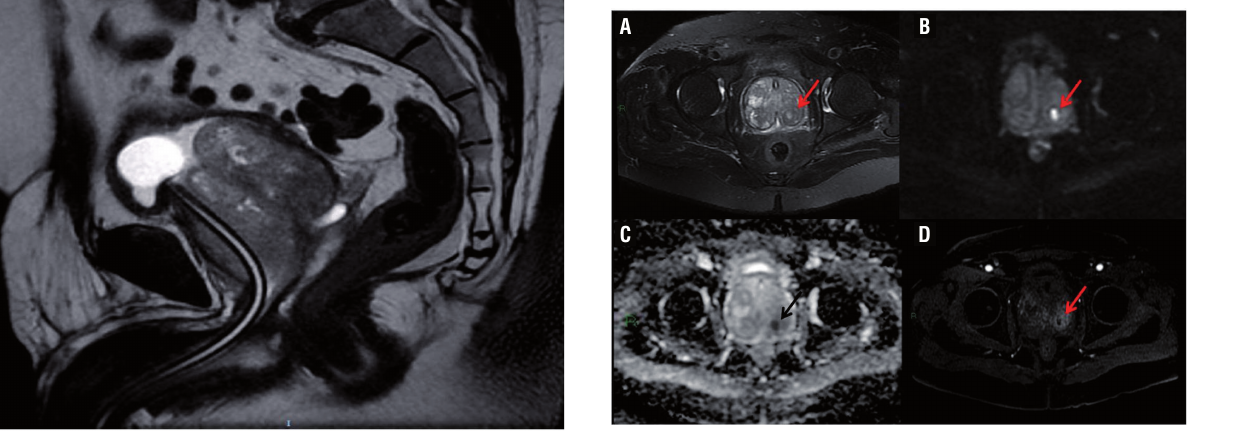
Figure 3 - Prostate MRI showing a small nodular area (arrows) in the left posterior mid-third of the transition zone. This lesion shows liquid content on T2-weighted images (A), and marked diffusion restriction (B), with corresponding ADC map (C) and intense peripheral enhancement (D), findings suggestive of an